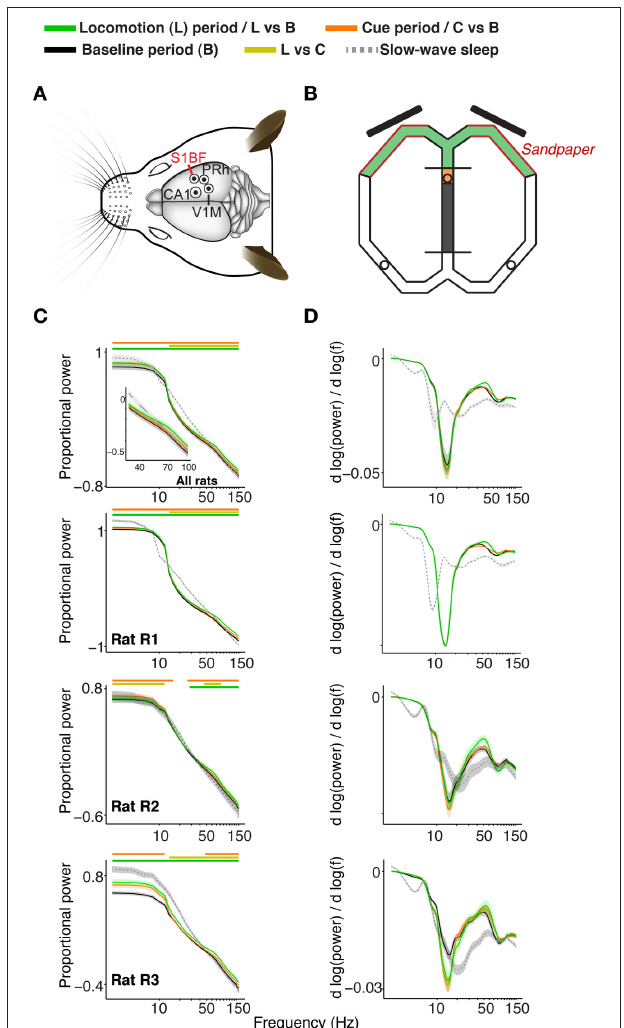
FIGURE 1 | Recordings, task, and characteristics of power spectra for S1BF electrodes. (A) Overview of recordings. Craniotomies of the four brain areas are shown by circles, made for the target areas S1BF, dorsal CA1, perirhinal cortex, and V1M. Eight recording (and one reference) tetrodes entered the brain per craniotomy. Adapted from Paxinos and Watson (2006). (B) Overview of the figure-eight maze. During the baseline period (gray), the rat is confined to the middle arm in the ITI confinement space by the two plexiglas barriers. Toward the end of the ITI, a sound indicates to the rat that the visual stimuli will appear if he breaks the infra-red photo-beam in the orange-shaded area. One second after breaking the infra-red beam, the S + and the S- cue appear on the two 15 inch screens (black, oblique bars; onset of cue period, marked in orange). 4.2s after removed (end of cue period) and the rat is allowed to make a response by entering either the left or the right arm. We refer to the 4.5–6.5s period after cue onset as the locomotion period, when the rat approximately traversed the maze segments shown in green. The red walls close by the screens are covered by sandpaper cues which were indicative of the size of an upcoming reward. The circles show the locations of the three ceramic cups where the rat obtained his pellet rewards upon correct choices. (C) Average power spectra (normalized as explained in main text) as a function of frequency. Power spectra are shown on logarithmic (base 10) scale, and were, for all periods, normalized by dividing by the sum of power across frequencies for the baseline period. Inset shows data for frequency